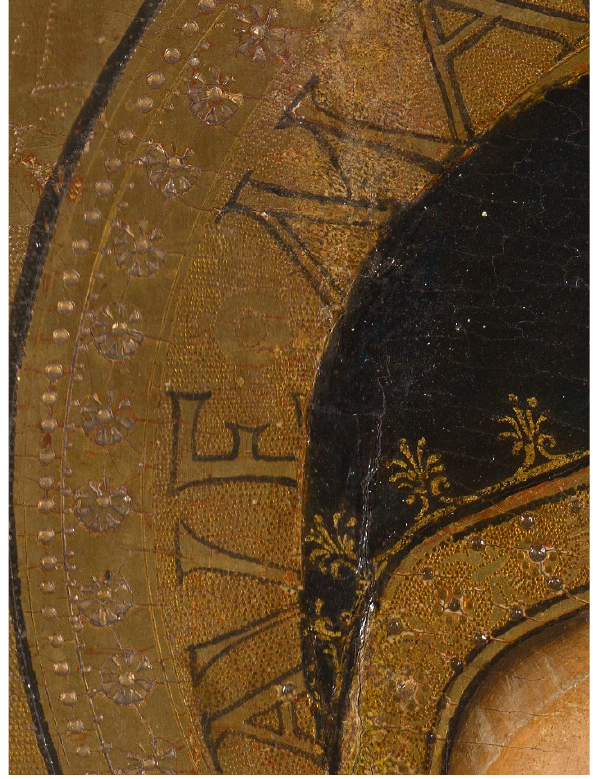
Figure 17 . Detailed view of the gold leaf